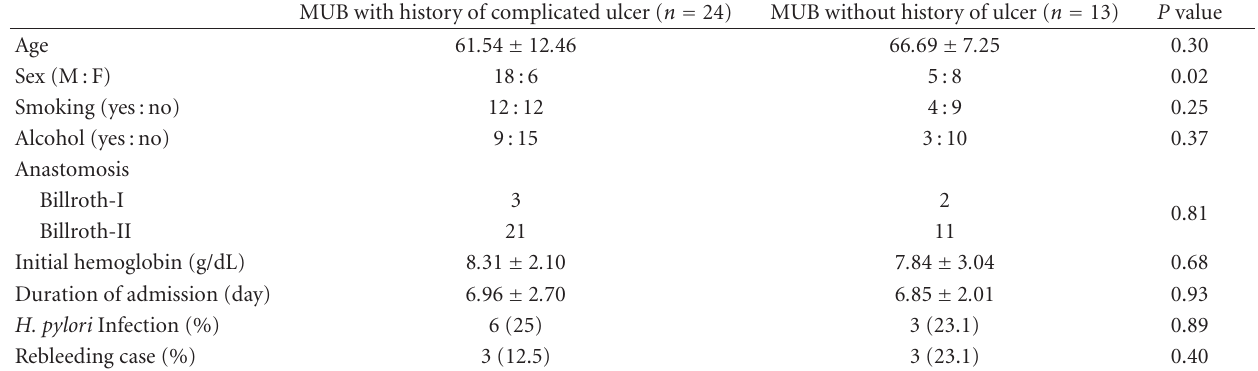
Table 2: Characteristics and clinical outcomes of MUB according to the history of a peptic